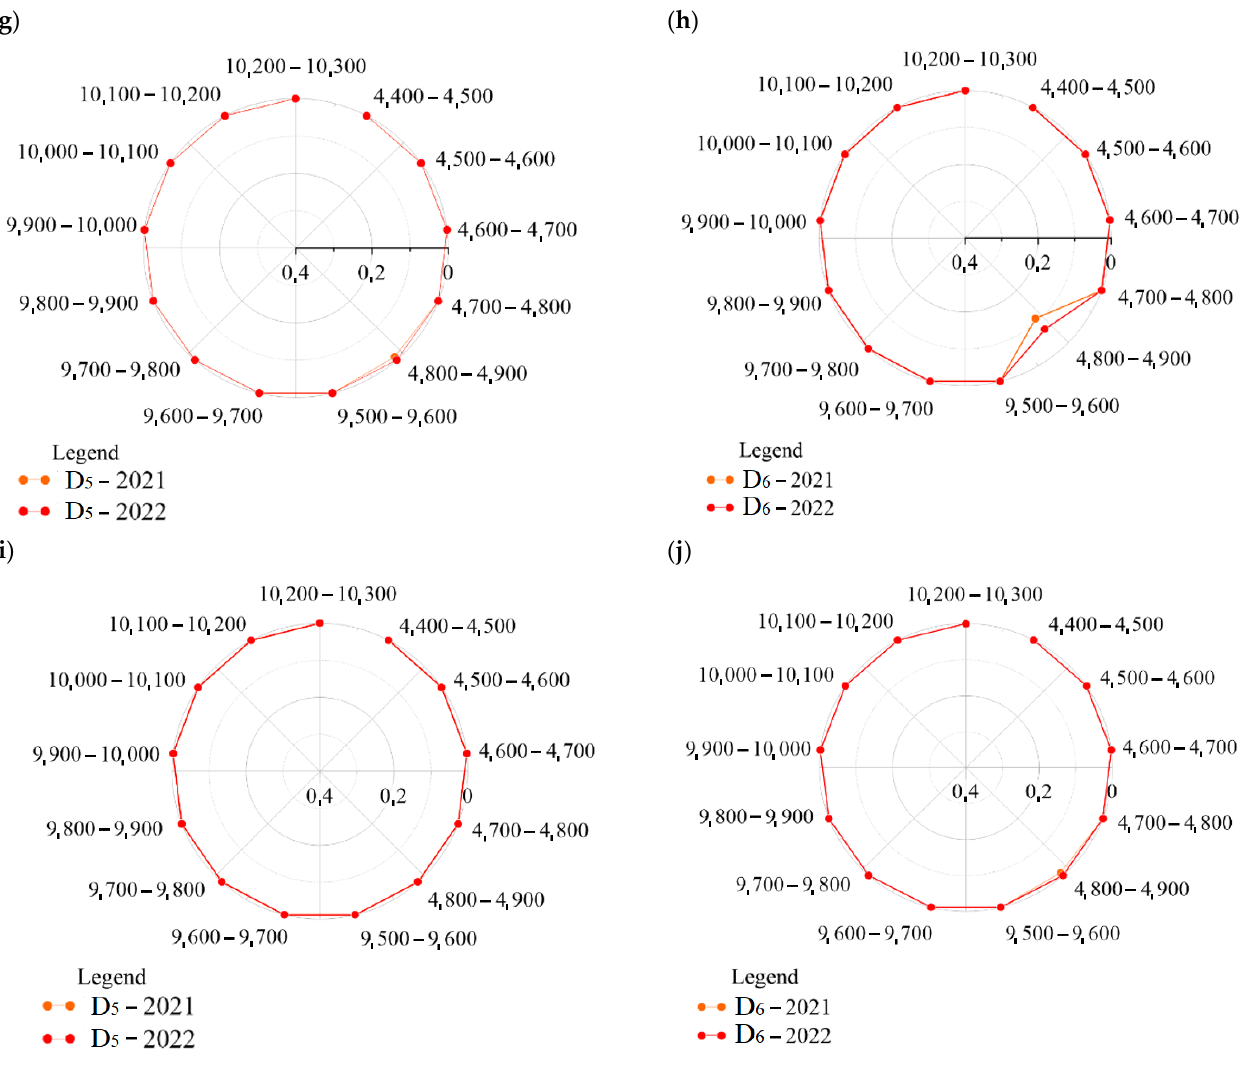
Figure 11. Confrontation of the relative assessment (relative estimates) D 5 and D 6 parameters in the time horizons of M 1 ÷ M 4 : ( a ) D 5 object Nos. R 143_1_1 and R 143_1_2 ; ( b ) D 6 object Nos. R 143_1_1 and R 143_1_2 ; ( c ) D 5 object No. R 143_1_2 ; ( d ) D 6 object No. R 143_1_2 ; ( e ) D 5 object No. R 144_1 ; ( f ) D 6 object No. R 144_1 ; ( g ) D 5 object No. R 161_1 ; ( h ) D 6 object No. R 161_1 ; ( i ) D 5 object No. R 161_2 ; and ( j ) D 6 object No. R 161_2.